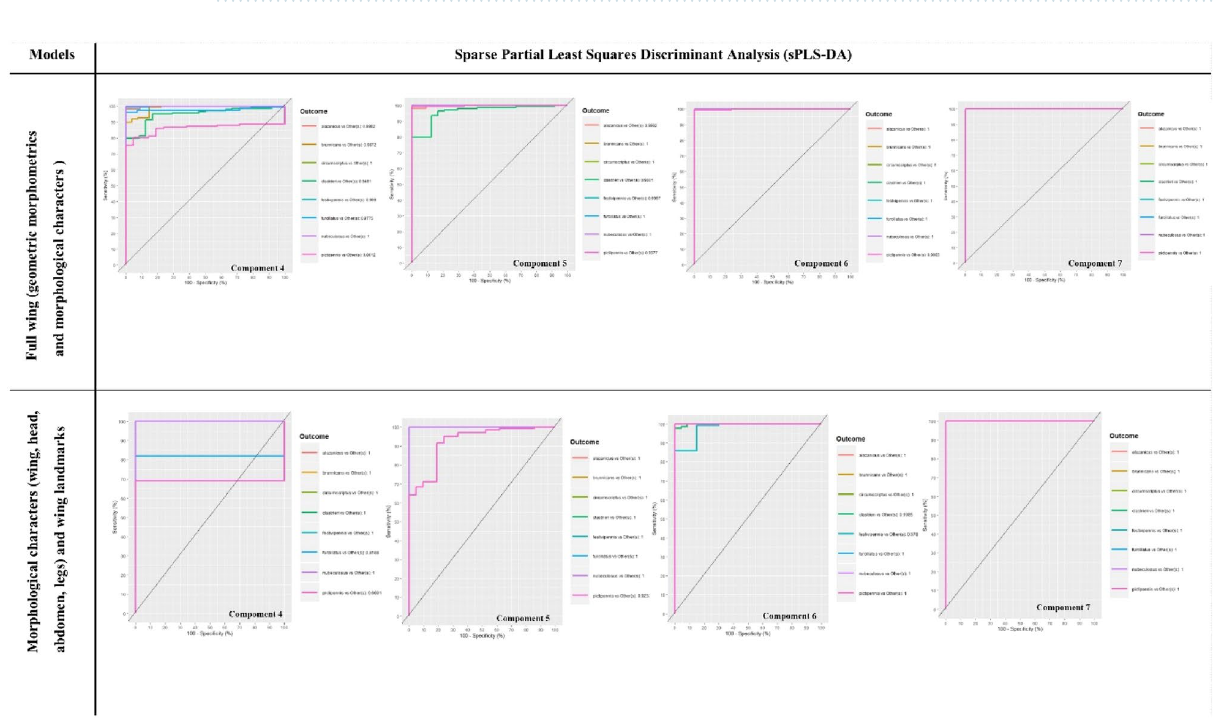
Figure 6. The ROC curve of the “ Full wing ” and “ Full model ” obtained with sparse partial least squares discriminant analysis (sPLS-DA) according to the components. A perfect result would be an area under the curve (AUC) of